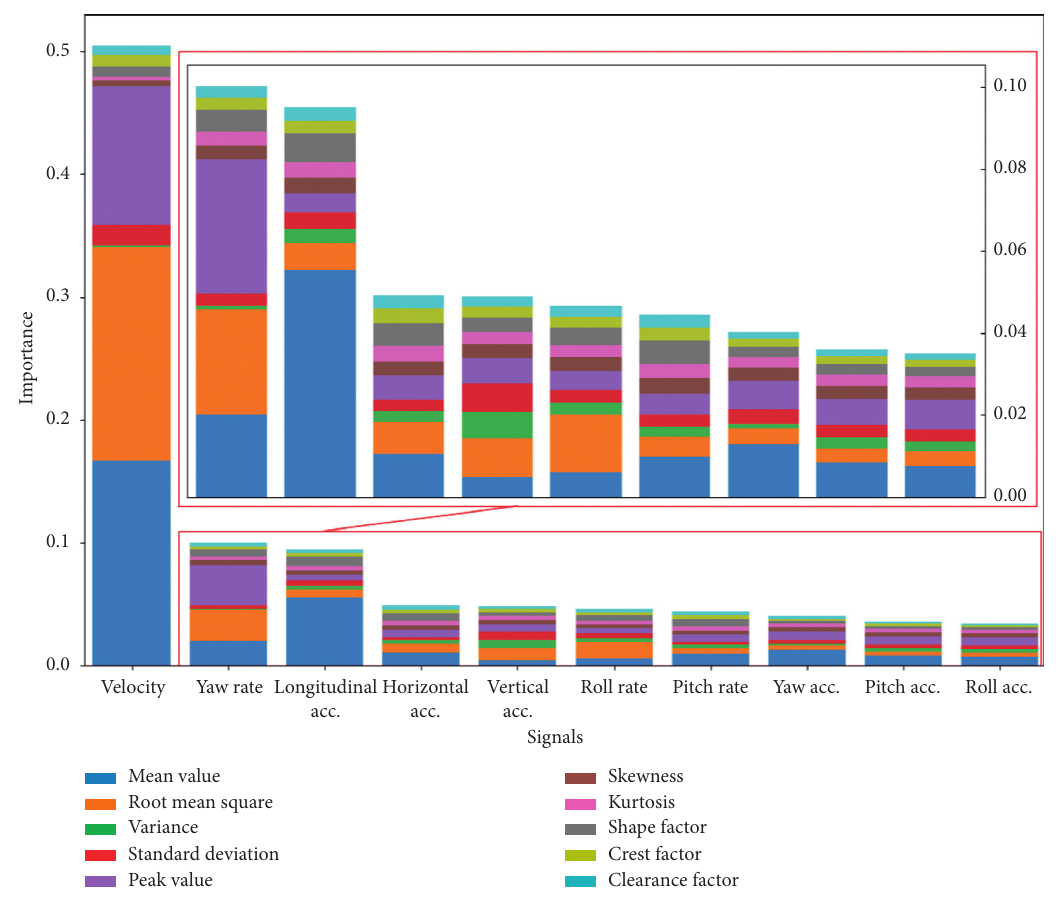
Figure 6: Feature importance